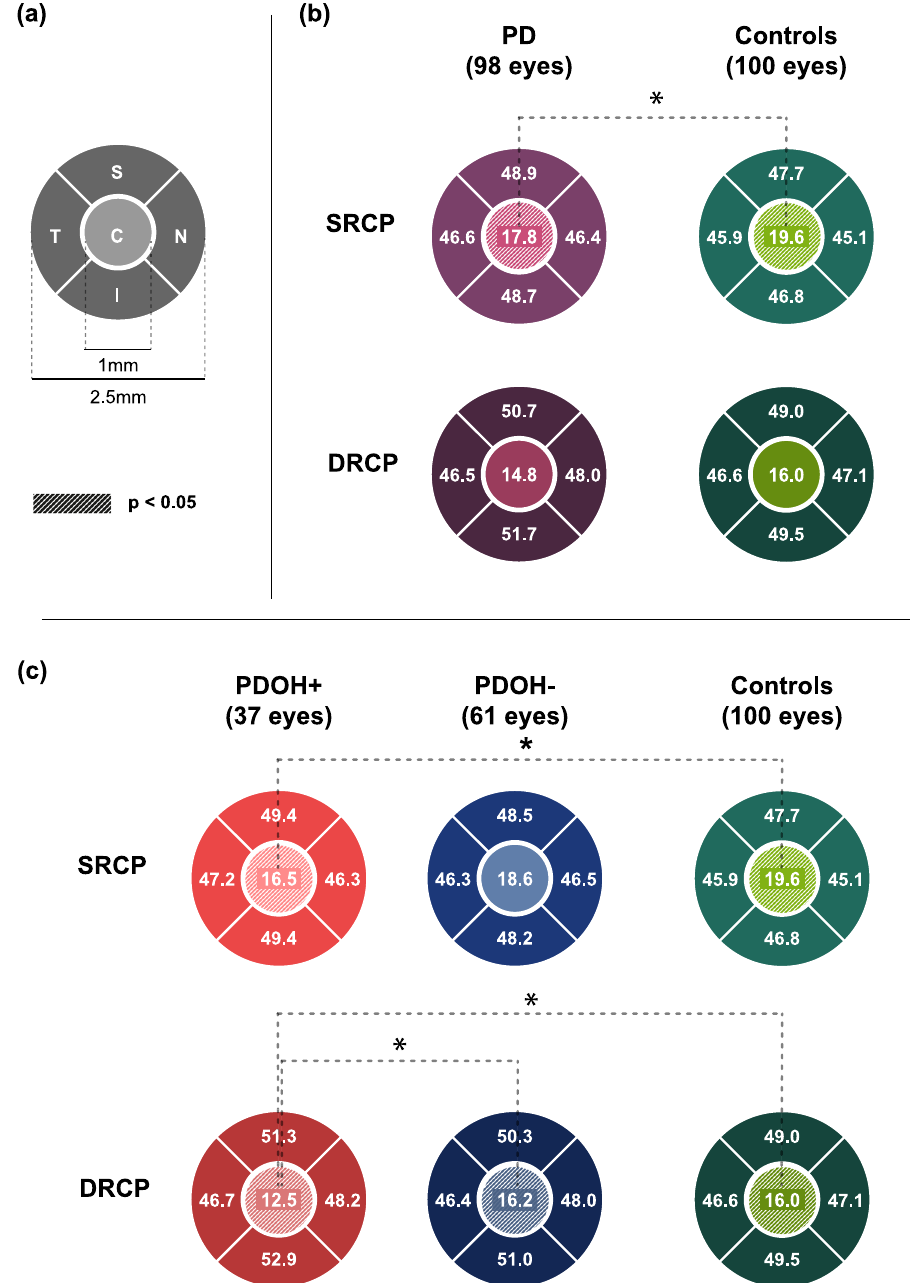
Fig. 1 Comparisons of OCTA parameters between patients with Parkinson ’ s disease and healthy controls. Schematic diagram and size of OCTA subregions ( a ). The Parkinson ’ s disease (PD) patients had lower super fi cial retinal capillary plexus (SRCP) vessel density in the central region than controls ( b ). The PD patients with orthostatic hypotension (PDOH + group) showed a lower vessel density in the DRCP central region than the PD patients without orthostatic hypotension (PDOH − ) and the control group ( c ). The SRCP vessel density in the central region in the PDOH + group was lower than that in the control group but was non-signi fi cant compared with the PDOH − group ( c ). The asterisk indicates statistically signi fi cant. The hatched area represents statistical signi fi cance. The numbers represent the mean value of the vessel density. C center, T temporal quadrant, I inferior quadrant, N nasal quadrant, S superior